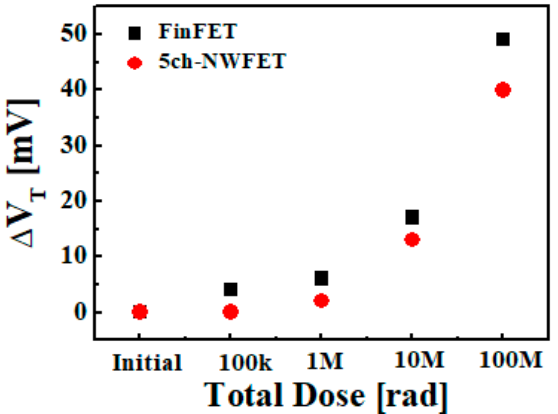
Figure 6. FinFET and 5ch-NW extracted the V T shift amount according to the increasing TID.